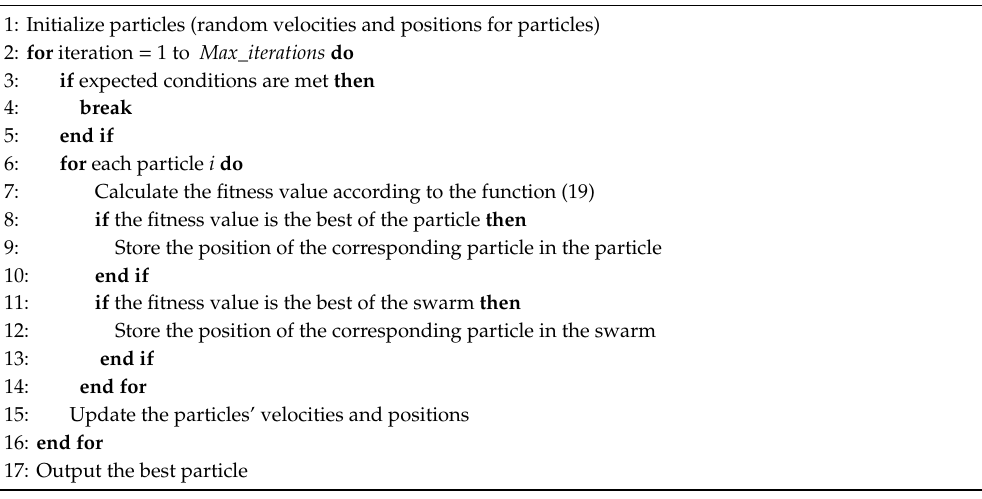
Algorithm 2 PSO-based UAV Trajectory